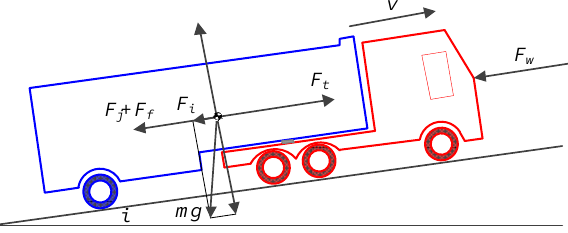
Figure 1. Vehicle longitudinal dynamics.